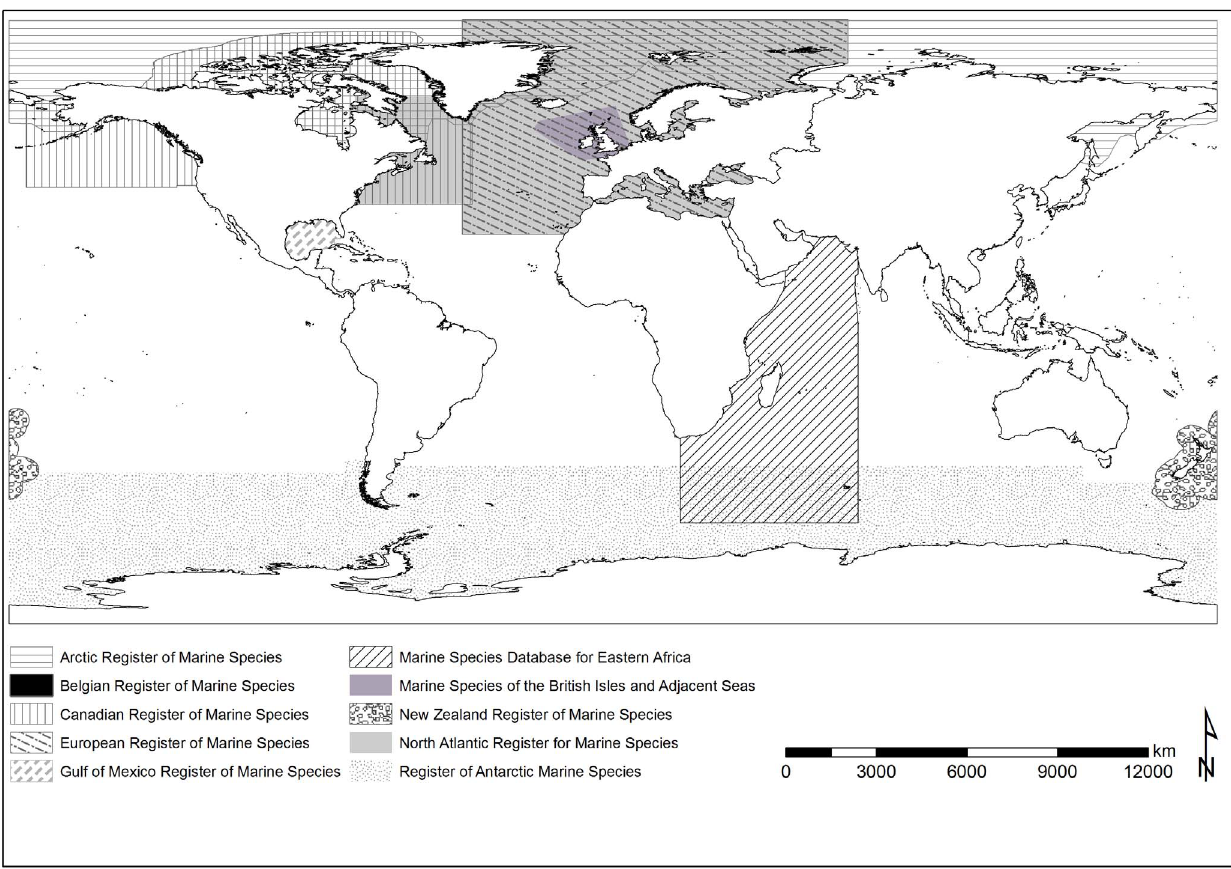
Figure 2. The approximate present geographic coverage of the larger Regional Species Databases (i.e. all-species inventories) within WoRMS.